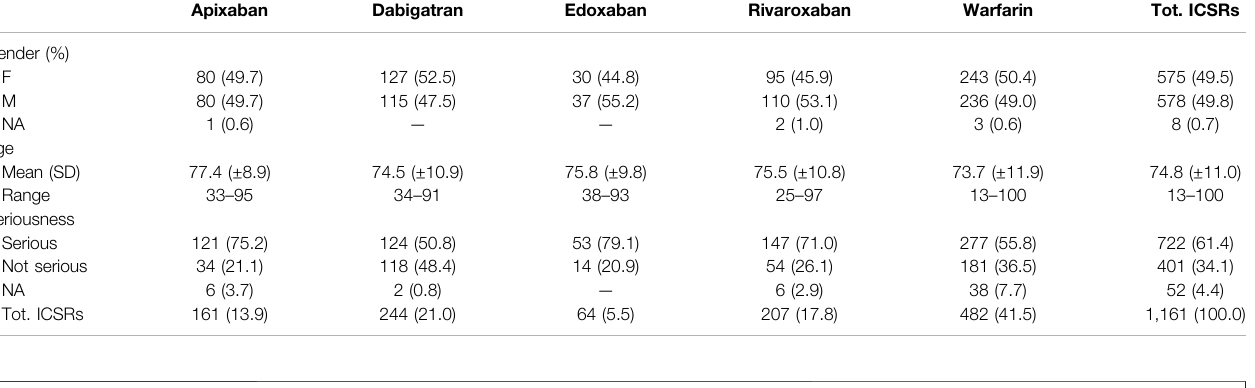
TABLE 1 | Oral anticoagulants related ICSRs reported in Campania Region and collected into RNF from January 1, 2008 to January 1, 2021 strati fi ed by gender, age and seriousness.